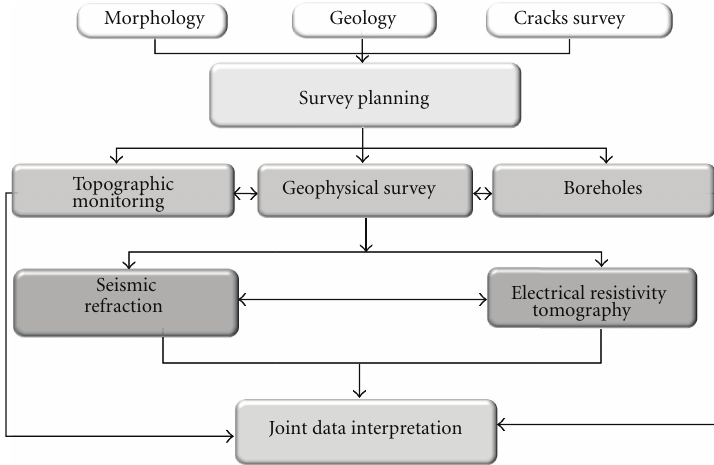
Figure 3: Flow chart of the surveys performed in the study area.